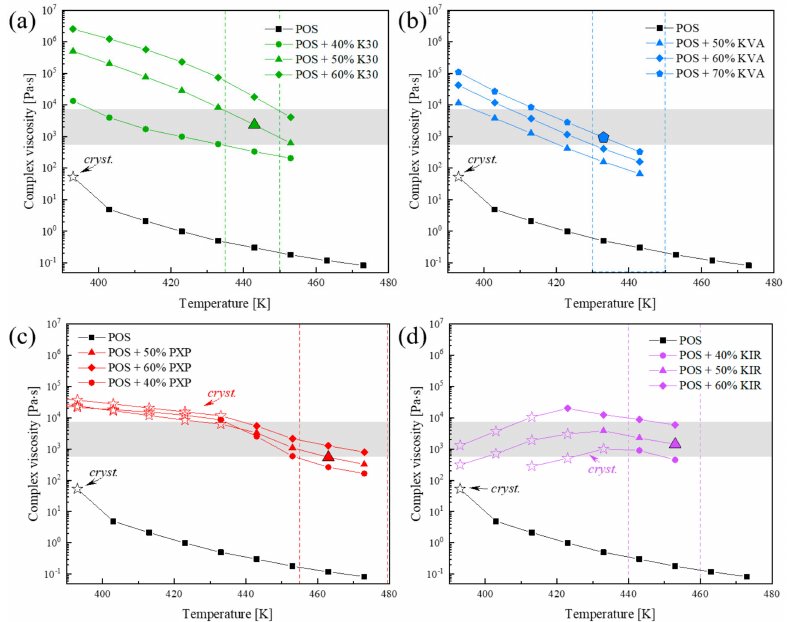
Figure 6. Oscillation temperature sweep of binary drug–polymer mixtures of ( a ) POS + K30, ( b ) POS + K30, ( c ) POS + PXP, and ( d ) POS + KIR from 443 K (for POS + KVA), 453 K (for POS + K30 and POS + KIR), and 473 K for (POS + PXP), to 393 K, at an angular frequency of 1 Hz.